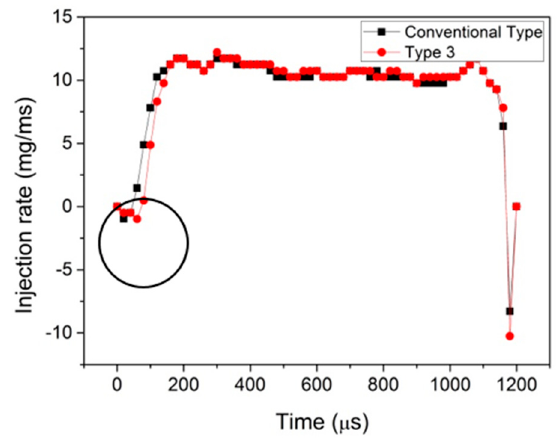
Figure 18. Comparison of the injection rate between conventional type and Type 3 DPI.